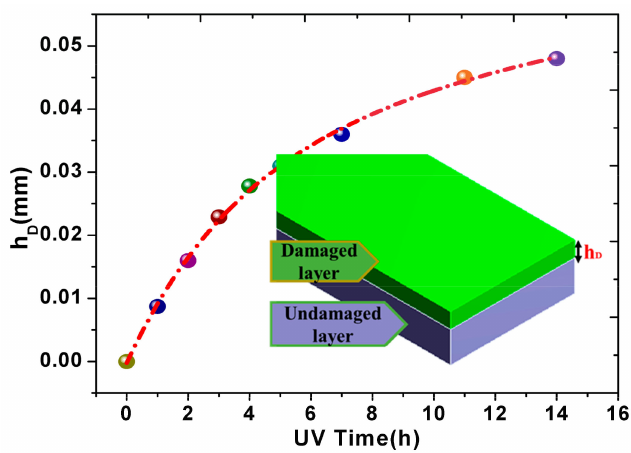
Figure 7. The damaged depth in PI films at different UV irradiation times.